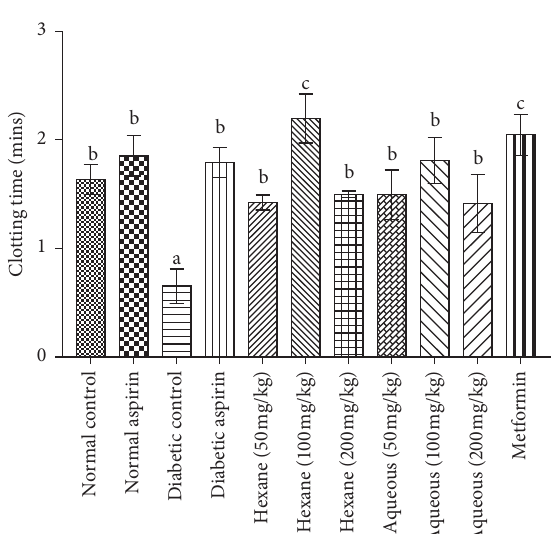
Figure 2: Clotting time in diabetic rats treated with different concentrations of aqueous and hexane fractions of C crepidioides b is significantly higher than a ( P < 0 . 01). c is significantly higher than a ( P < 0 . 001); n � 4.